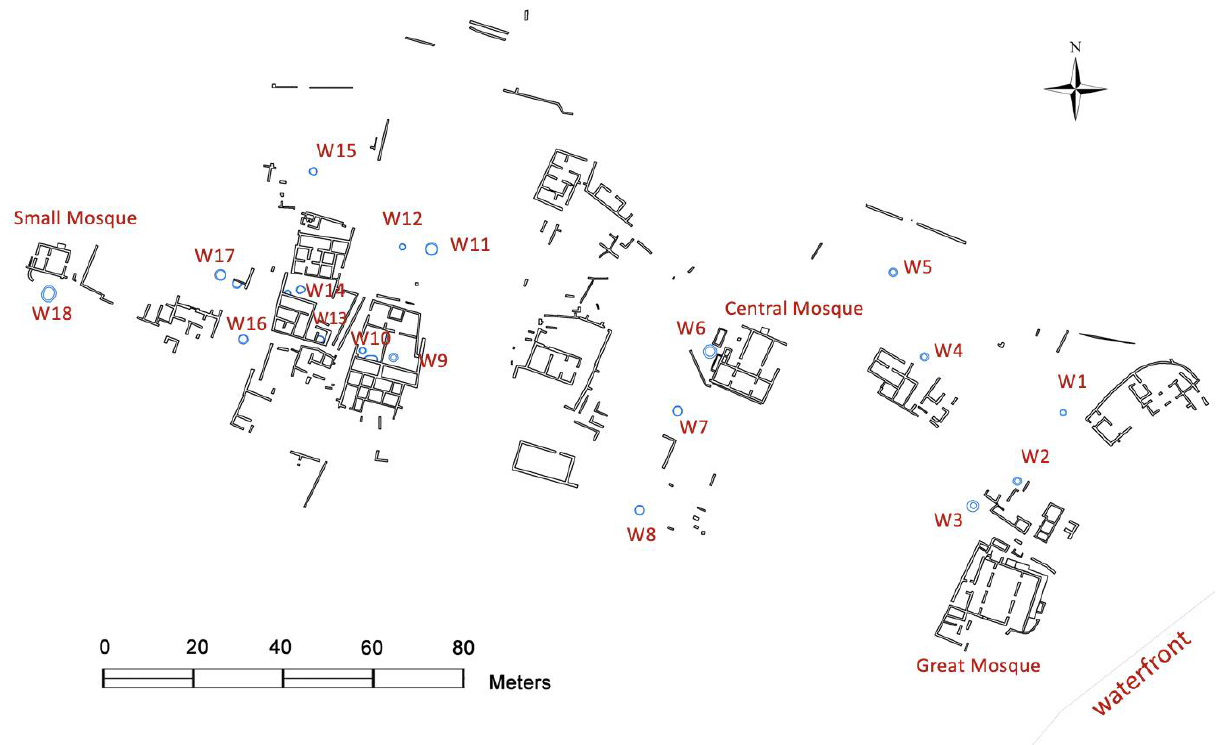
Figure 7. The layout plan of Jumba la Mtwana showing the numbered location of the wells. The figure also highlights that no wells were identified in the central part of the preserved town.